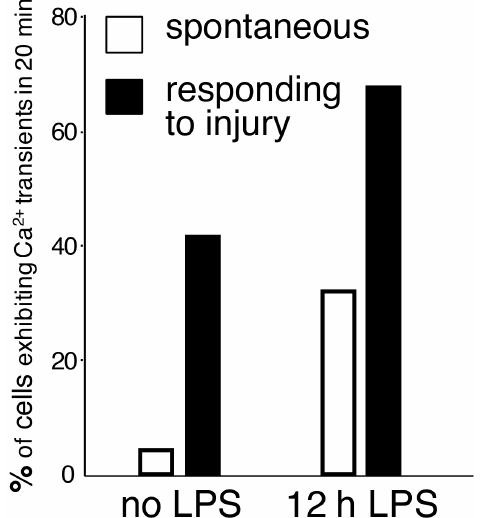
Figure 2. The frequency of spontaneous and evoked Ca 2+ transients in cortical microglia, calculated as a percentage of cells exhibiting at least one Ca 2+ spike during a 20-min recording session. Ca 2+ activity was detected with GCaMP5G and two-photon laser scanning microscopy. In this model, only 4% of resting microglia exhibited spontaneous Ca 2+ activity (no LPS, white bar). The frequency of Ca 2+ transients increased 8-fold after LPS exposure (12 h LPS, white bar). In cells extending processes towards the focal laser injury, 67% of microglia displayed Ca 2+ activity (12 h LPS, black bar). Adapted from [16].